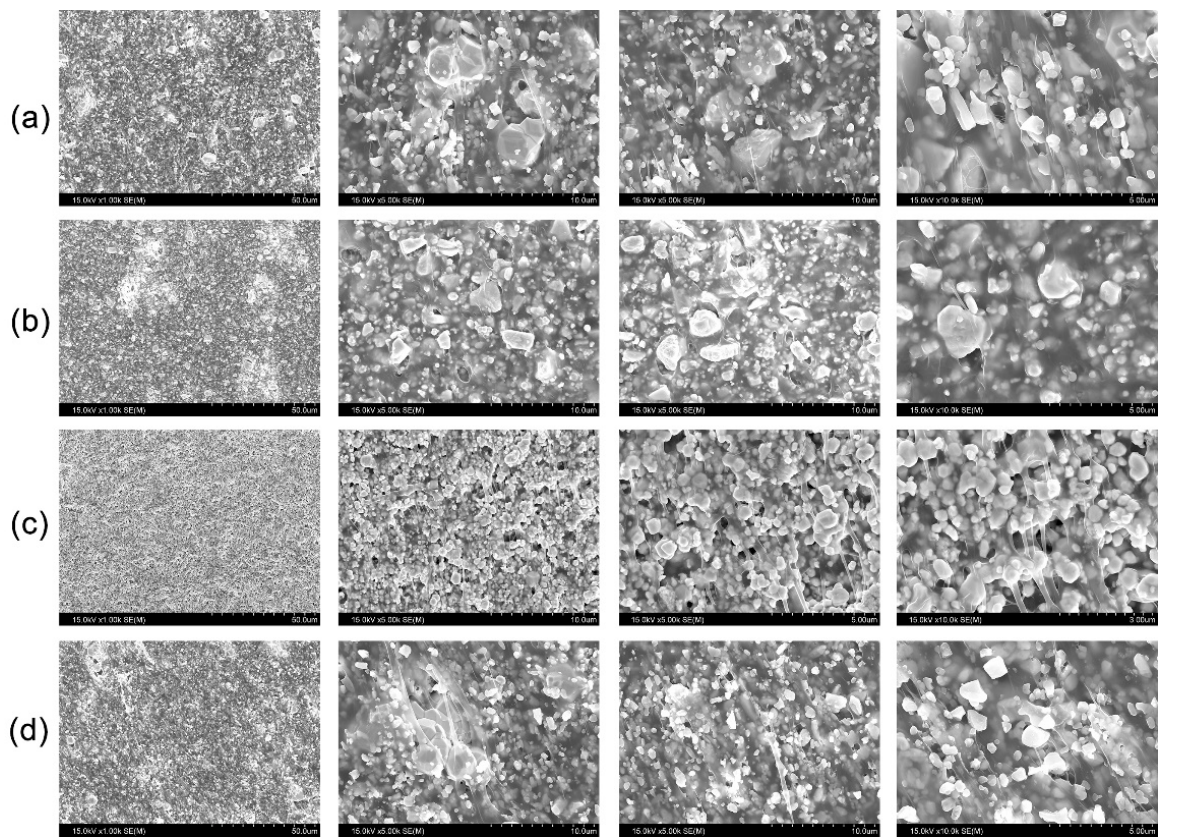
Figure 5. Cross-sectional particle analysis results of shield samples: ( a ) PWBa-80 (W, Ba), ( b ) PWBi-80 (W, Bi), ( c ) PW-85 (W), and ( d ) PWBaBi-80 (W, Ba, Bi).